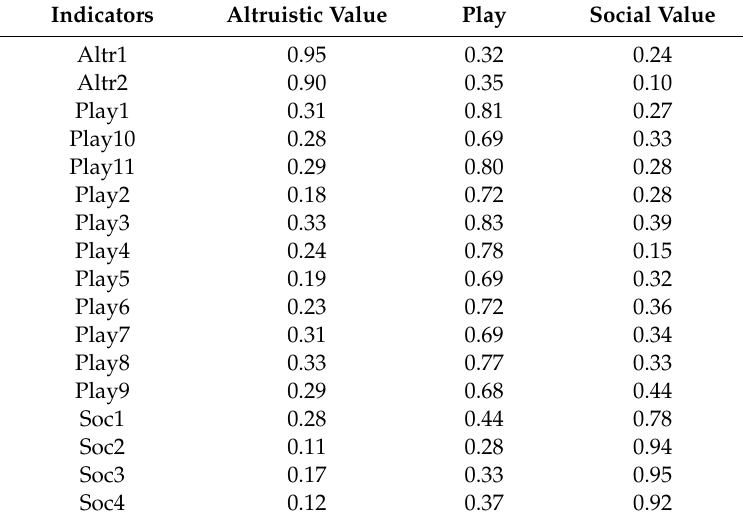
Table 4. Indicators’